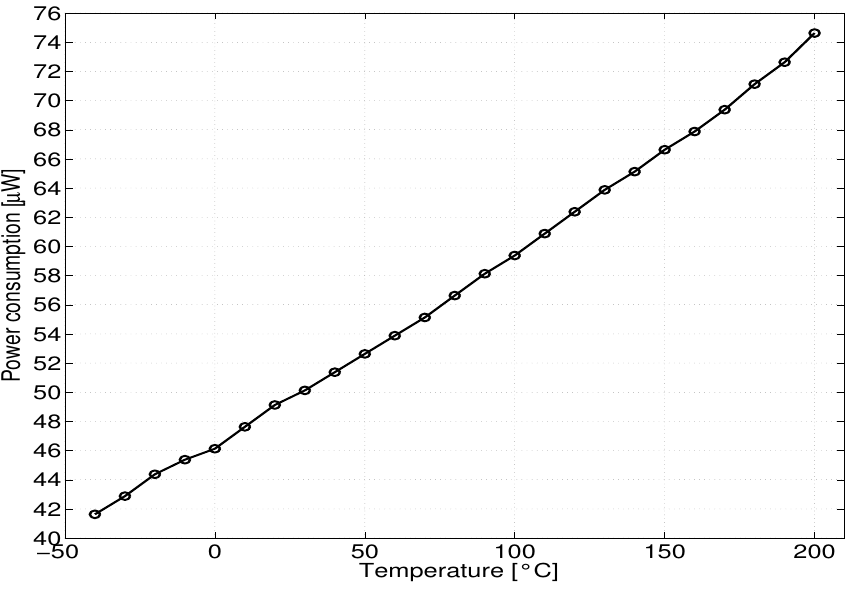
Figure 9. Measured current consumption versus